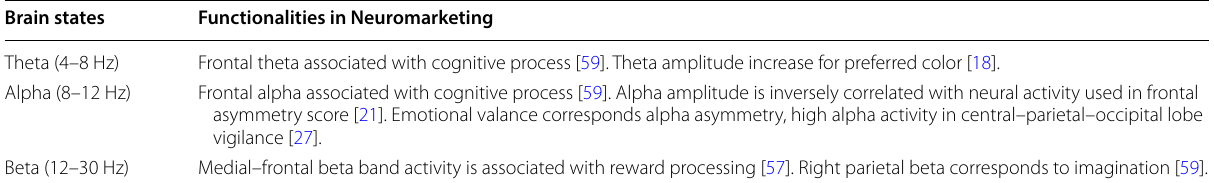
Table 3 Functionalities of brain states used in Neuromarketing research Brain states Functionalities in